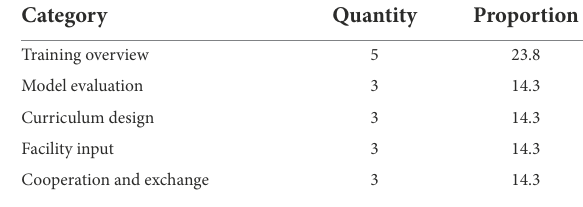
TABLE 2 Basic information of survey content questions.